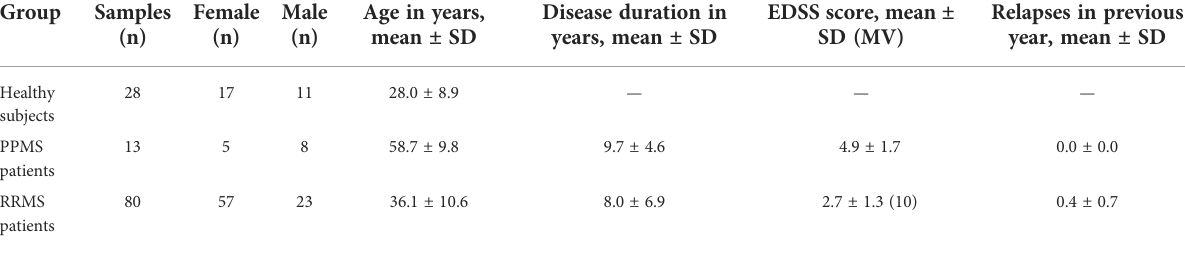
TABLE 2 Basic information on the study cohort.